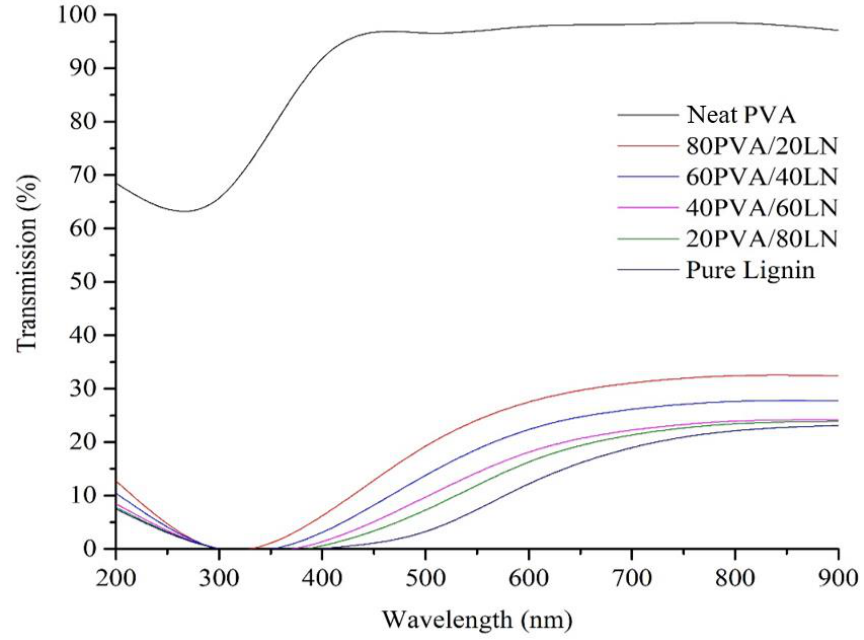
Figure 3. UV-vis transmittance curves of PVA and PVA/LN films.